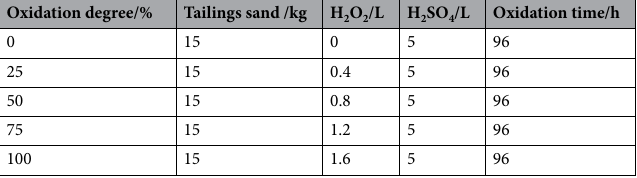
Table 1. Test scheme.